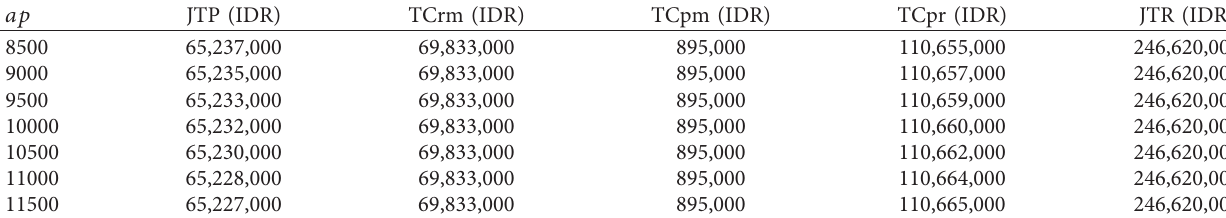
Table 8: Sensitivity analysis of the effect of ap on cost, revenue, and profit.